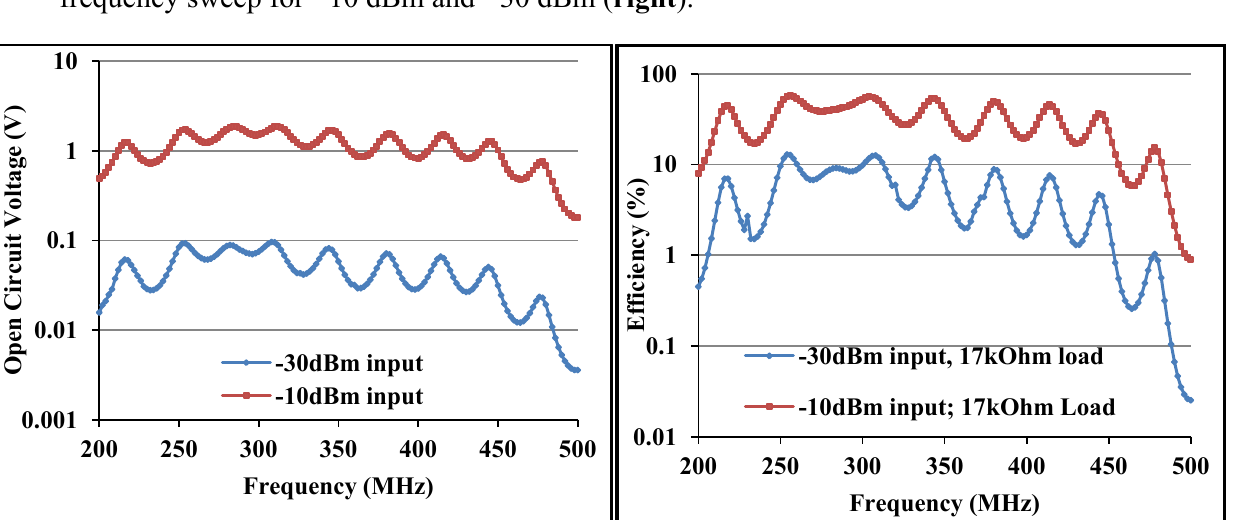
Figure 13. Measured open circuit voltage versus frequency sweep from 200 MHz to 500 MHz for −10 dBm and −30 dBm ( left ), measured efficiency at 17 kΩ load versus frequency sweep for −10 dBm and −30 dBm ( right